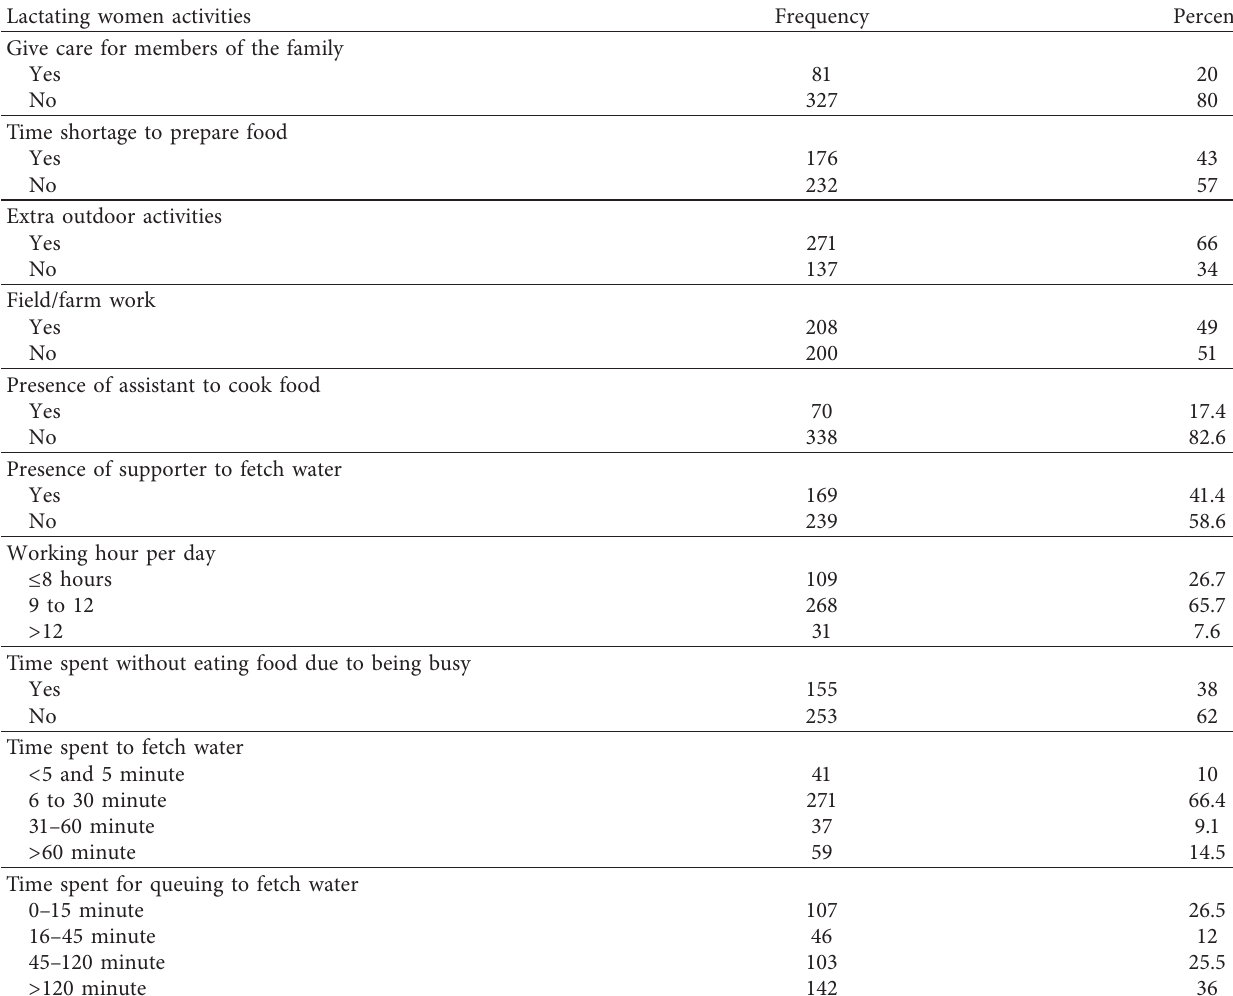
Table 2: Work burden of lactating mothers ( n � 408) in Lay Gayint District, South Gondar Zone, 2018. Lactating women activities